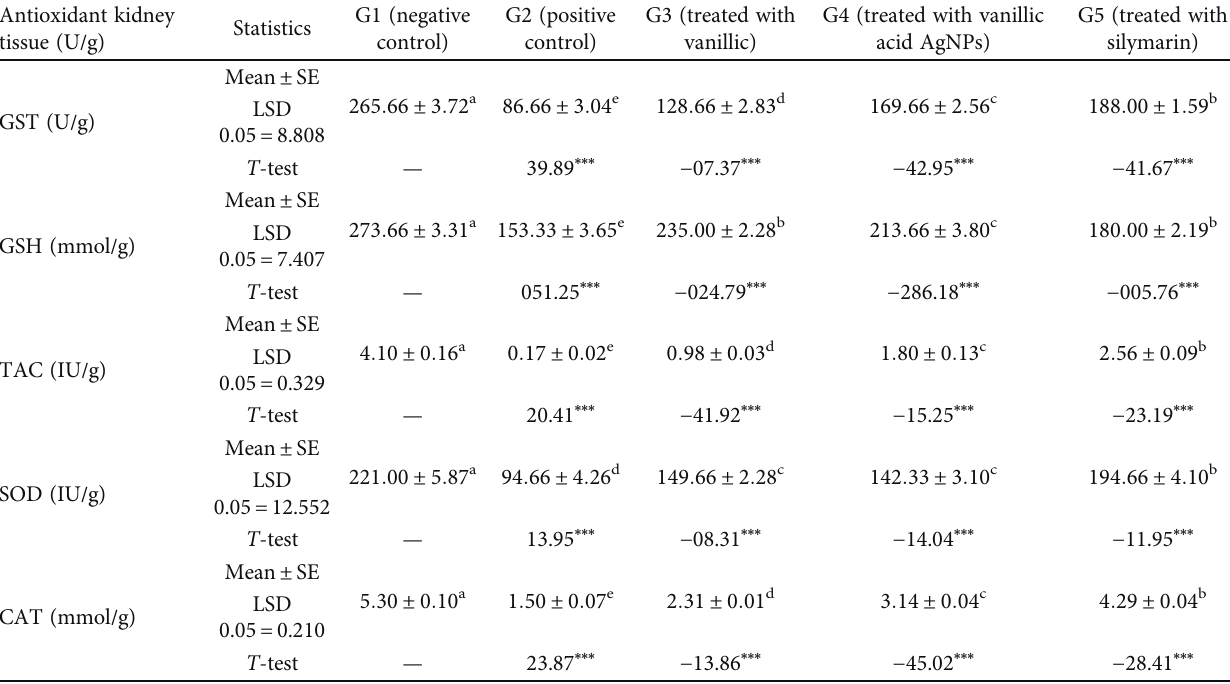
T -test values ***: signi fi cant at P < 0 : 001 . ANOVA analysis: means with di ff erent superscripts (a, b, c, d, or e) are signi fi cantly di ff erent at P < 0 : 05 . LSD: least signi fi cant di ff erence.